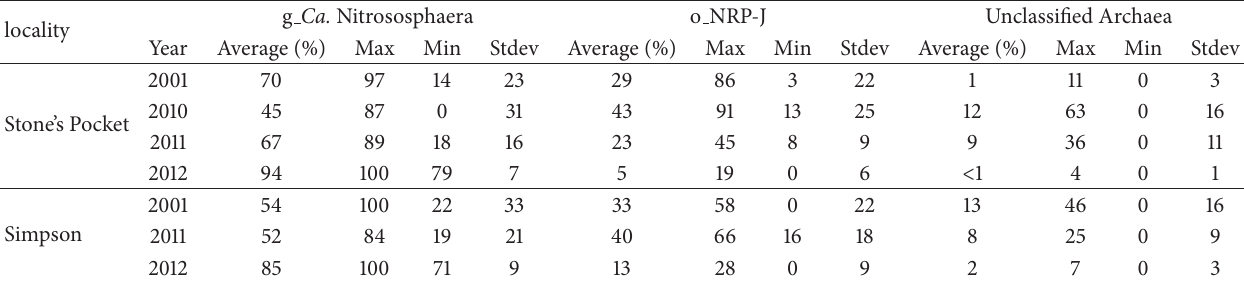
Table 2: Comparison of relative abundance of soil Archaea over time and between localities. g Ca. Nitrososphaera o locality